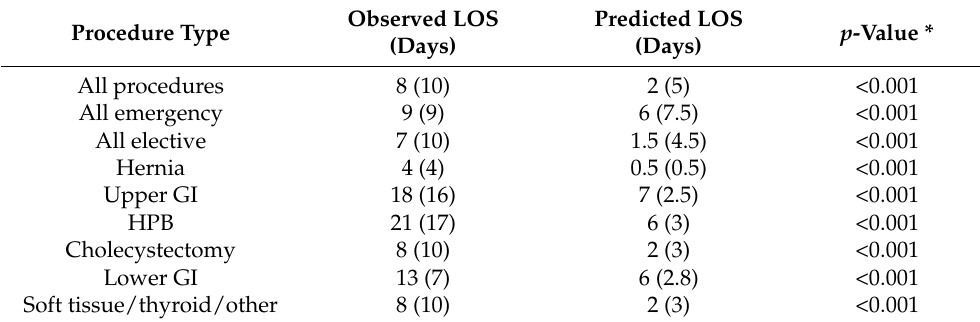
Table 3. Observed versus Predicted Length of hospital stay (LOS) of 471 elderly patients who underwent general surgery procedures using the ACS-NSQIP Surgical Risk